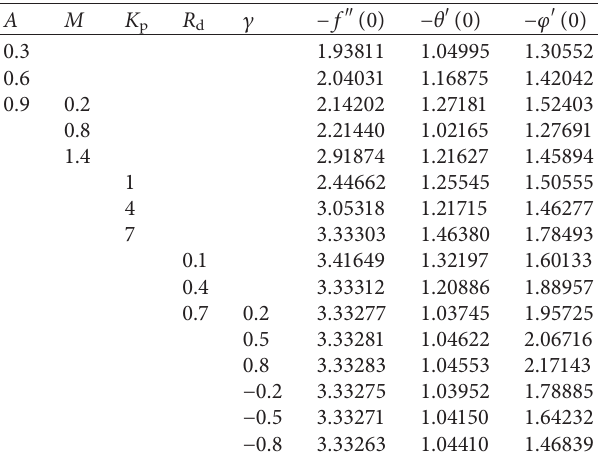
Figure 9: Effects of surface permeability parameter S on velocity on velocity d gradient and temperature profile. Table 2: Coefficients of skin friction, Nusselt number, and Sher- wood number.